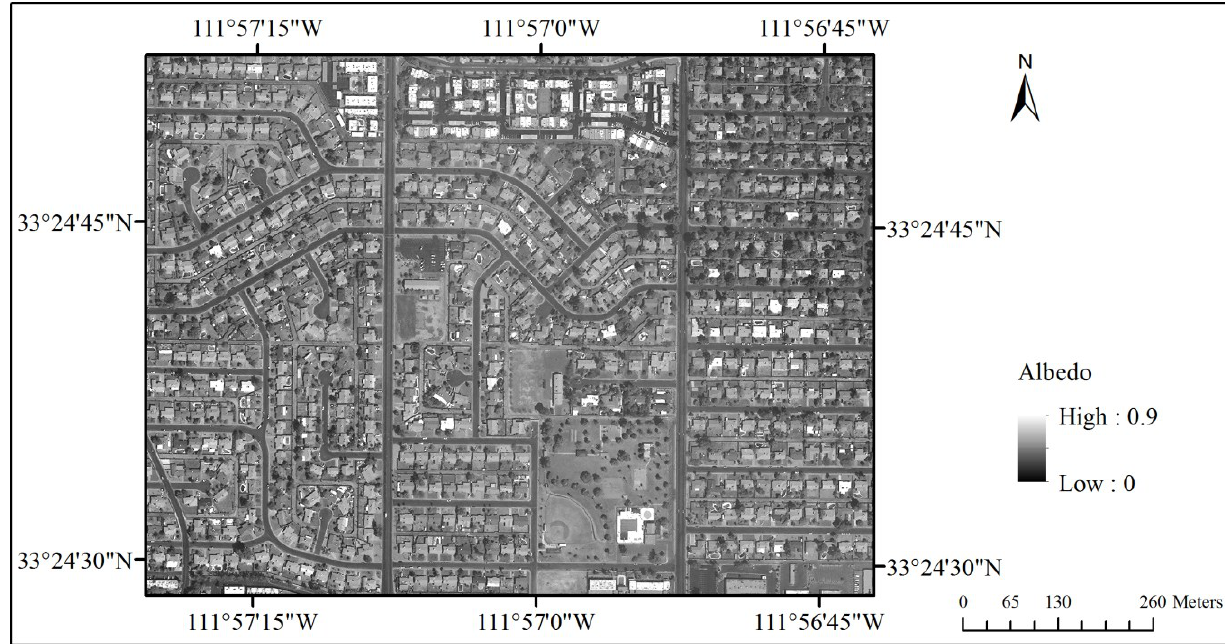
Figure 15. Albedo estimated from QuickBird